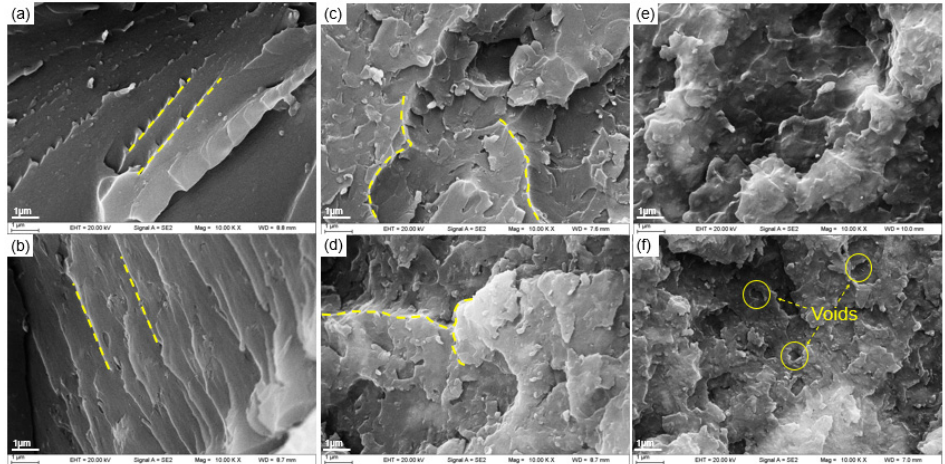
Figure 10. SEM images of tensile fracture surfaces for composites with different Sm 2 O 3 -APTES contents: ( a – f ): 0, 5, 10, 15, 20 and 30 wt%.